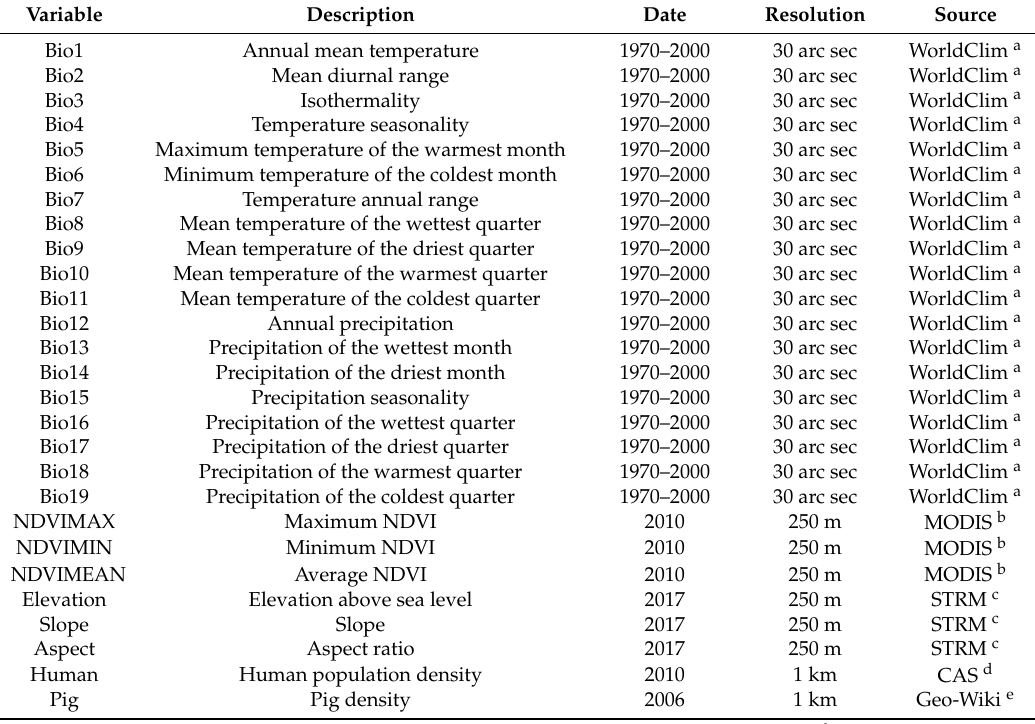
Table 1. Variables used in the